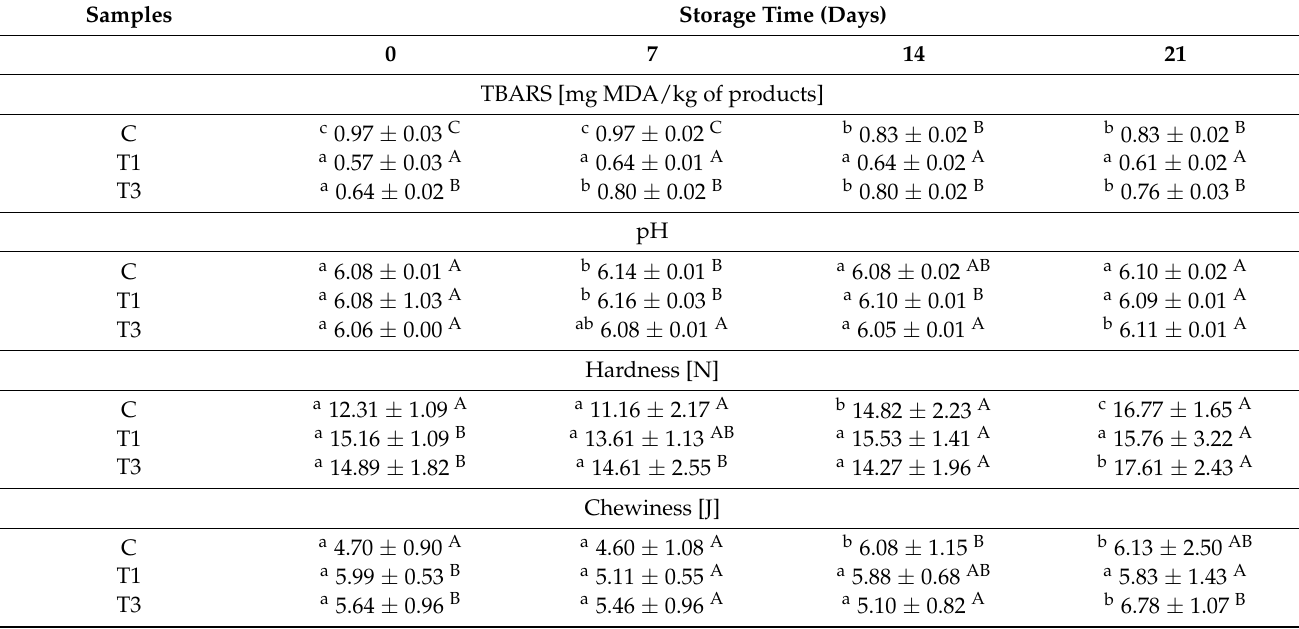
Table 1. The effect of different concentrations of turmeric and storage time on the lipid oxidation (TBARS), pH, hardness, and chewiness of hermetically packed pork